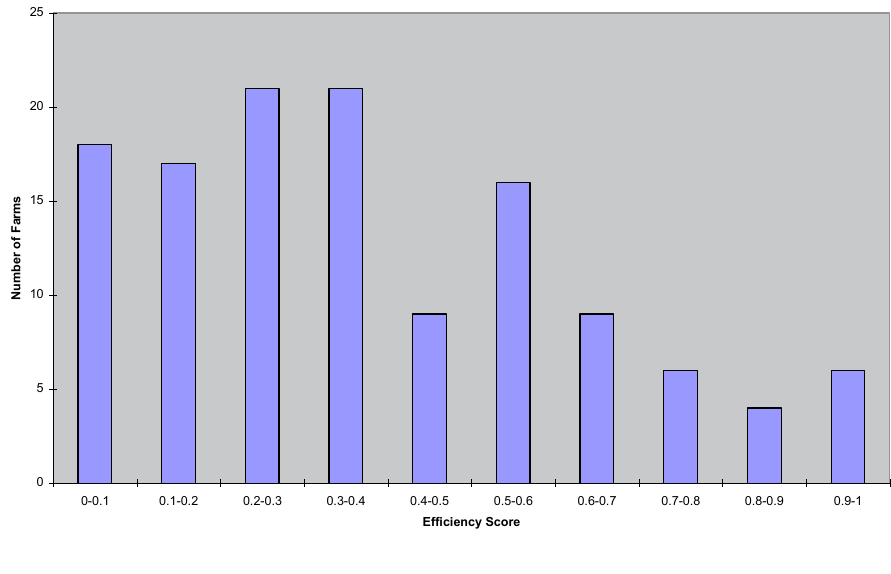
Figure 2. Frequency Distribution of Efficiency